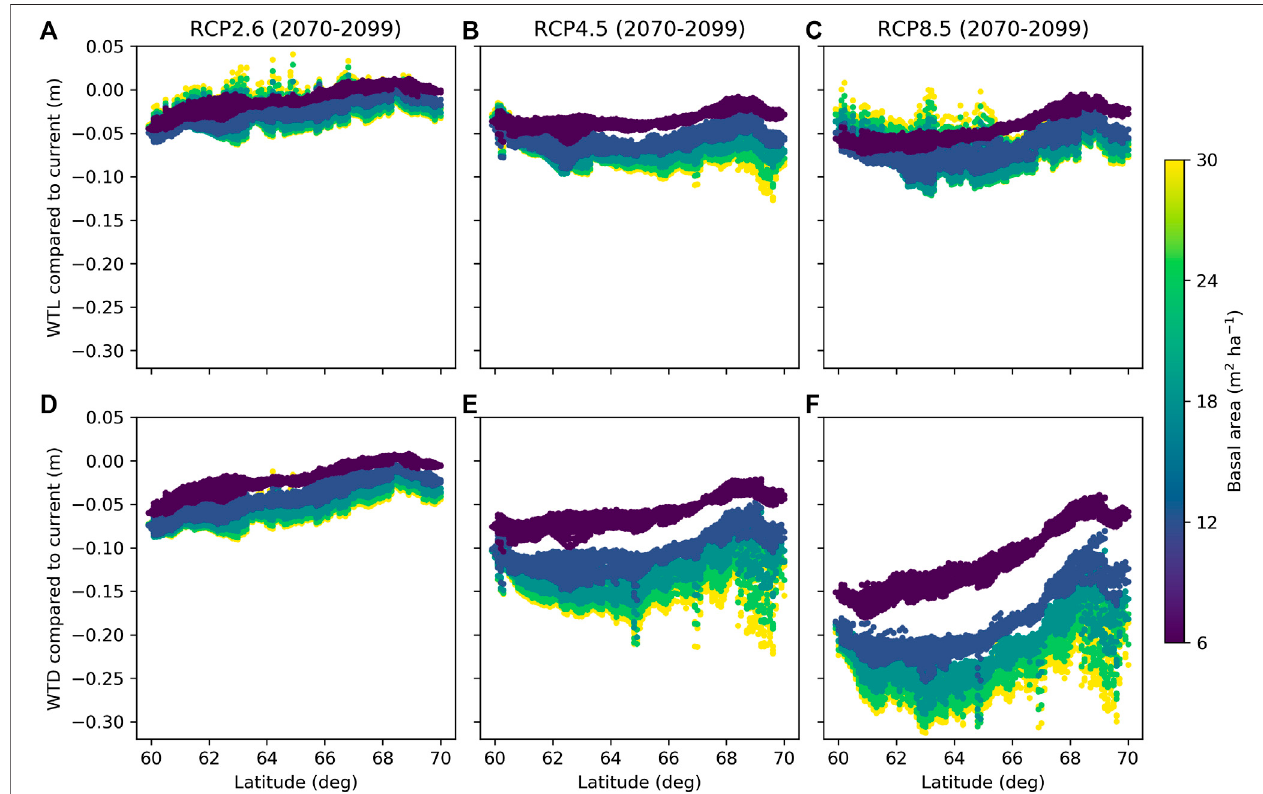
FIGURE 11 | Difference between mean June and October water table level (WTL) in future and current climate predicted for RCP2.6 (A,D) , RCP4.5 (B,E) , and RCP8.5 (C,F) , when accounting for the effect of atmospheric CO 2 on canopy stomatal conductance (see Eq. 10 ) (A,B) or when neglecting that effect (C,D) . Colors indicate fi ve different levels of the stand basal area, while other parameters were fi xed to values in Table 2 .